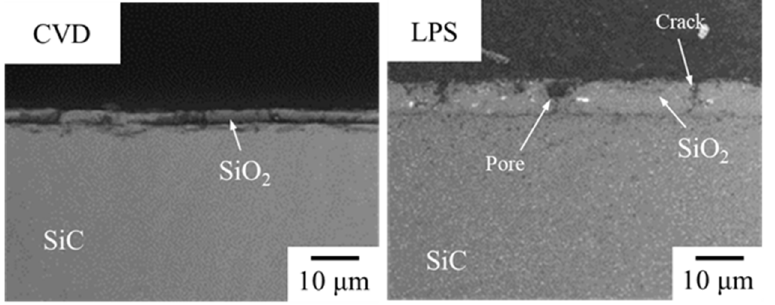
Figure 2. SEM images of cross-section of the CVD SiC and the LPS SiC following steam oxidation for 72 h at 1200 ◦